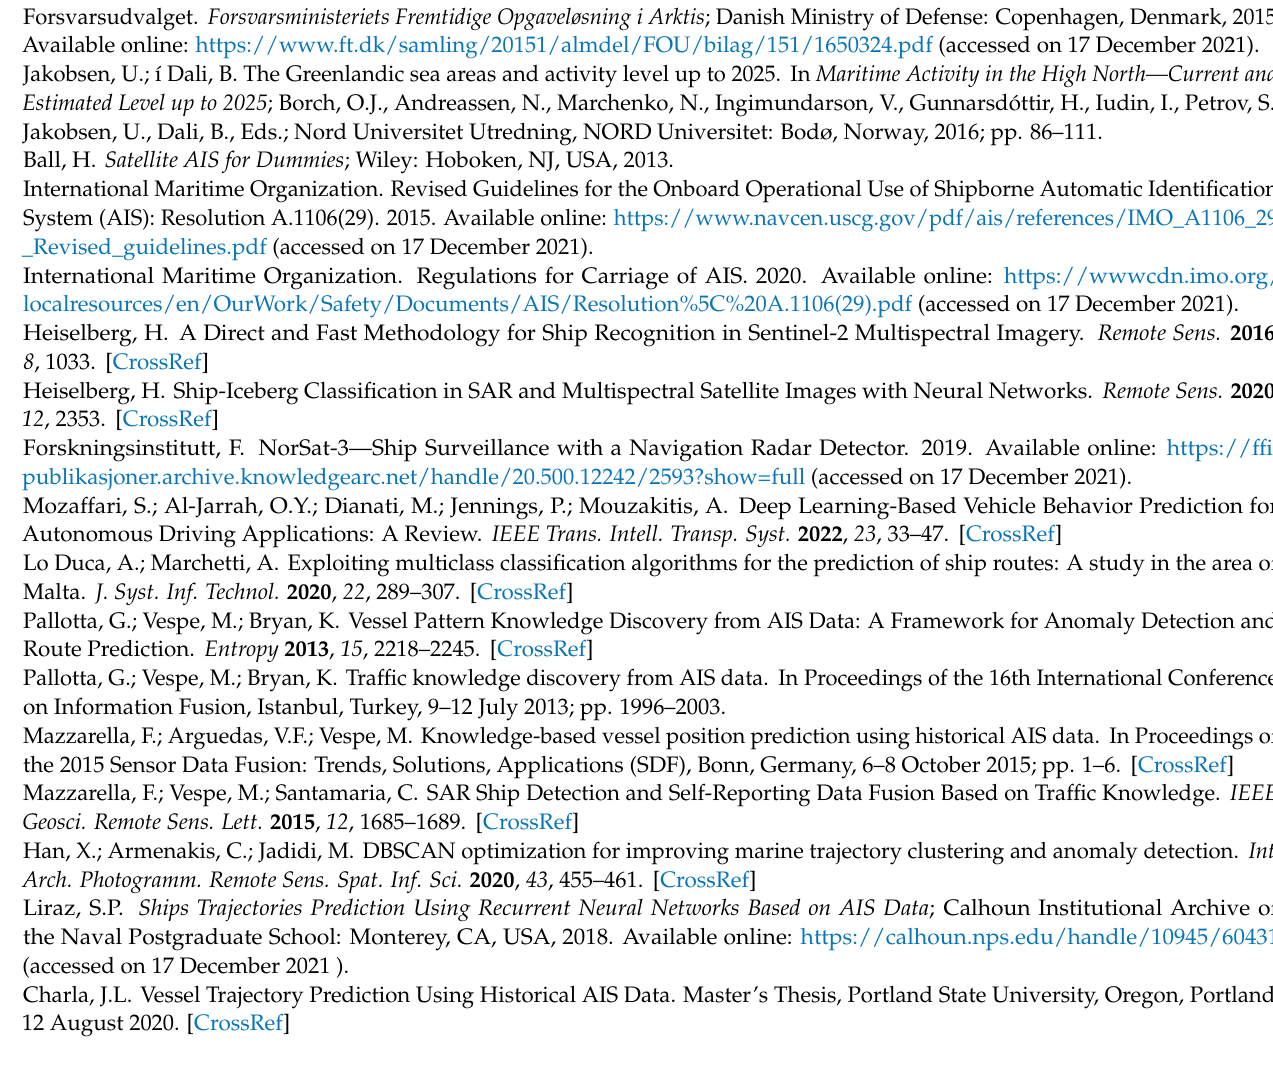
Figure A6. Illustration of the Long Short Term Memory cell. Here, f gate, g the gate gate and o t the output gate, each with input weights U , hidden state weights, W and t biases, b . ⊗ it the multiplication operator and ⊕ the addition